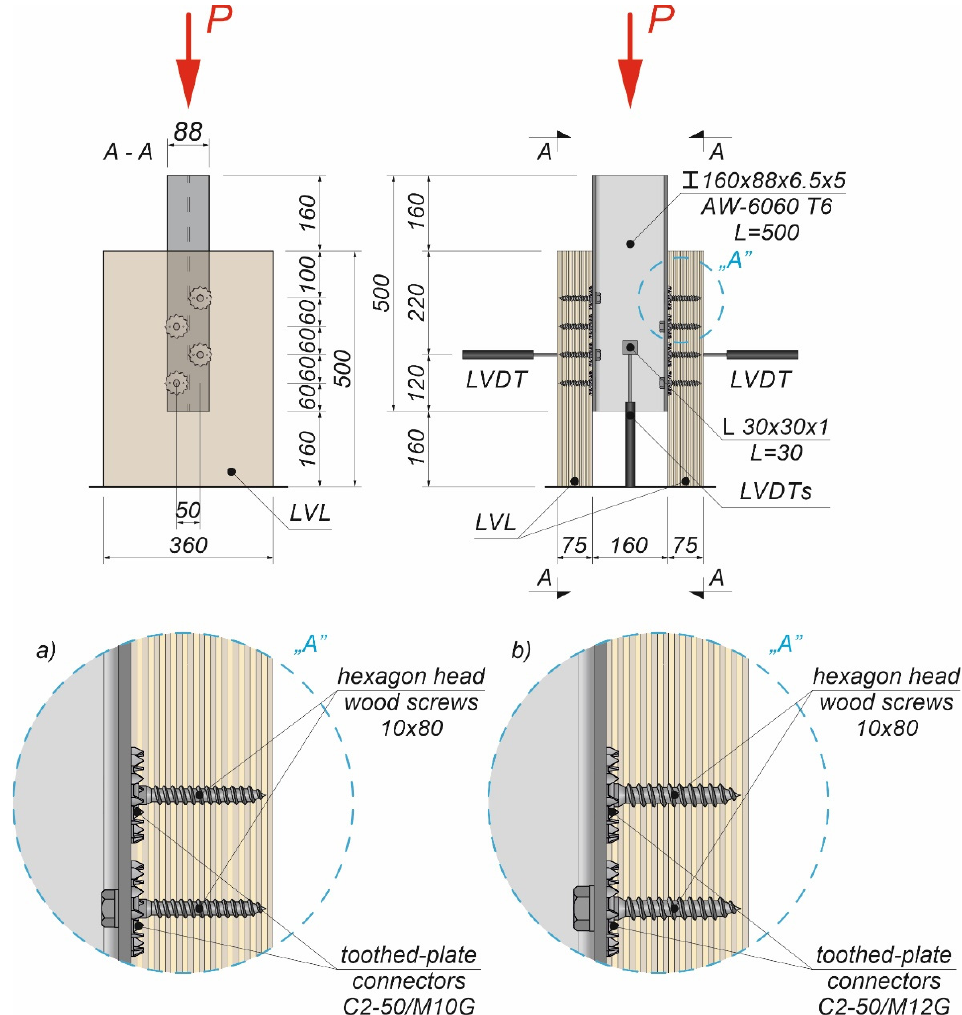
Figure 5. The location of the LVDTs on the specimen with reinforcing toothed plates: ( a ) screws 10 × 80 and toothed-plate connectors (type C2-50/M10G); ( b ) screws 12 × 80 and toothed-plate connectors (type C2-50/M12G, Bulldog).